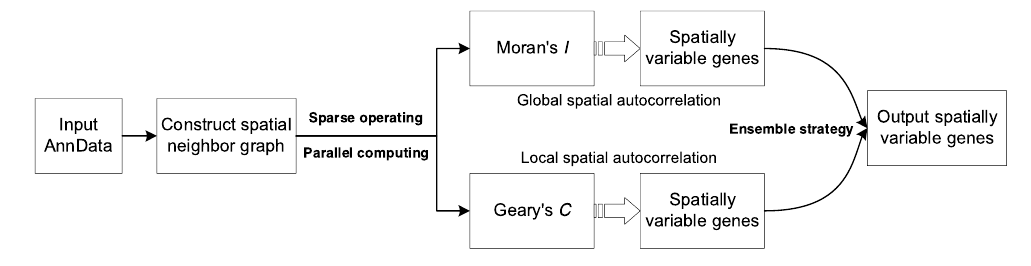
Figure 1. The framework of